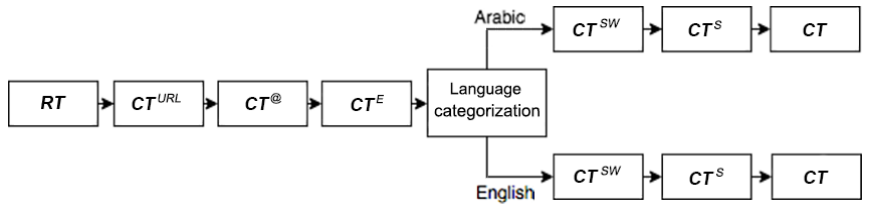
Fig. 2 Sequence of data processing